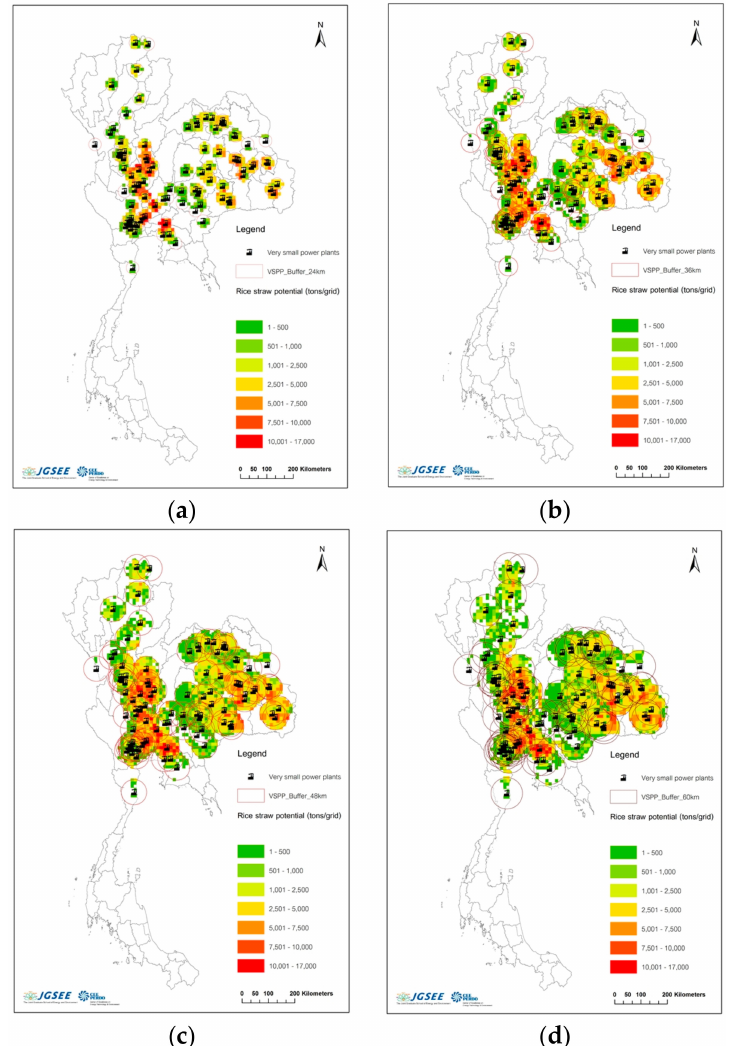
Figure 13. Efficiency of supply fuel for very small biomass power plants at various radii: ( a ) 24 km, ( b ) 36 km, ( c ) 48 km, and ( d ) 60 km. Table 7. Efficiency of supply materials for very small biomass power plants at various radii.